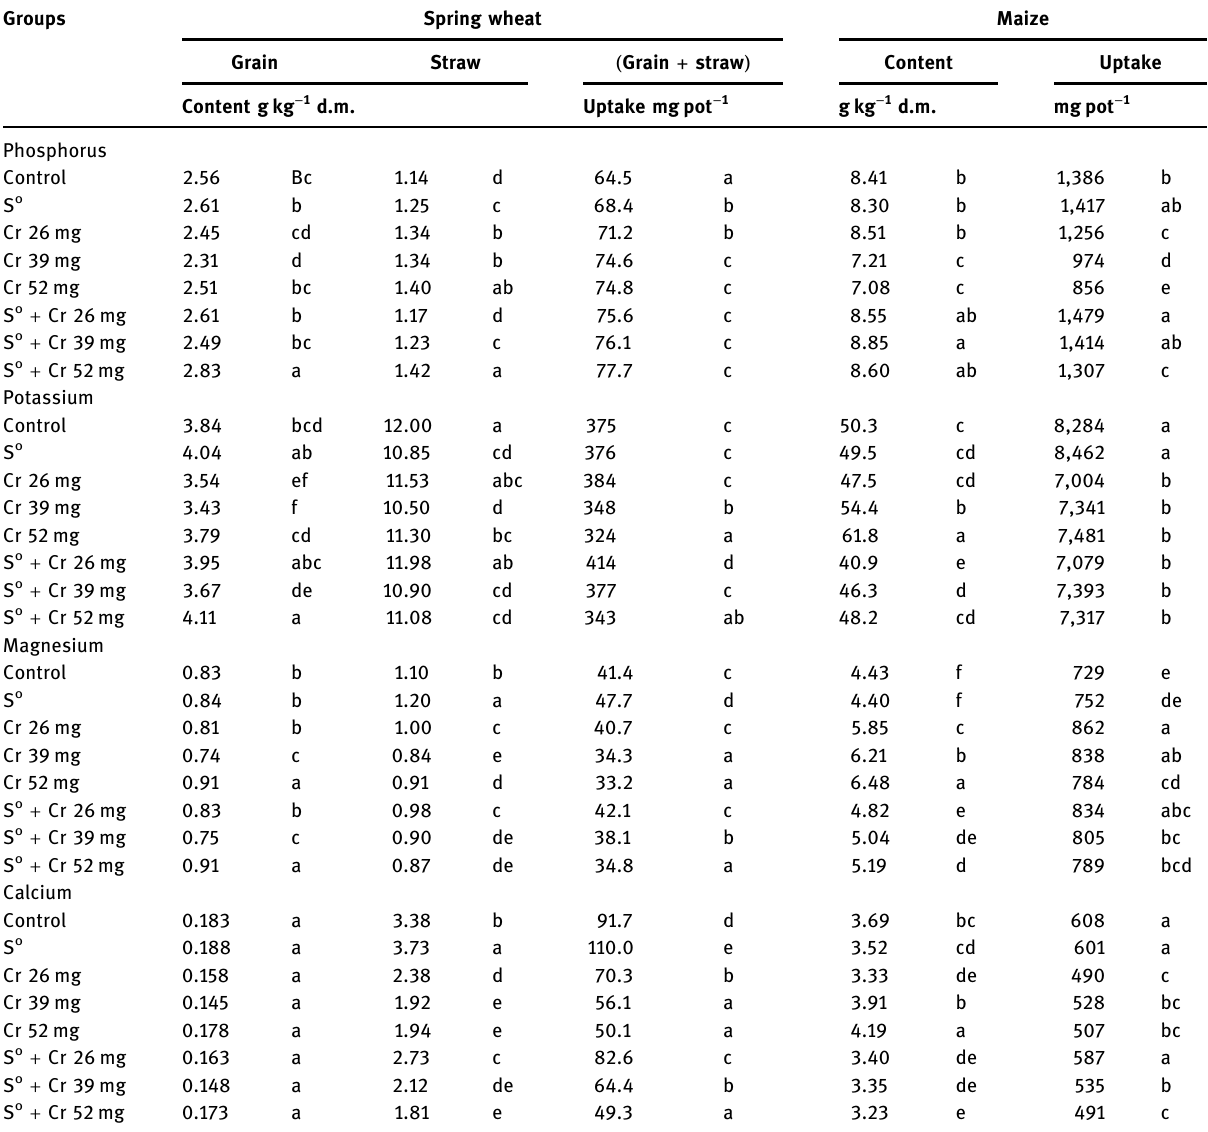
Table 4: Macroelements ( P, K, Mg, and Ca ) content and uptake in cultivated plants Groups Spring wheat